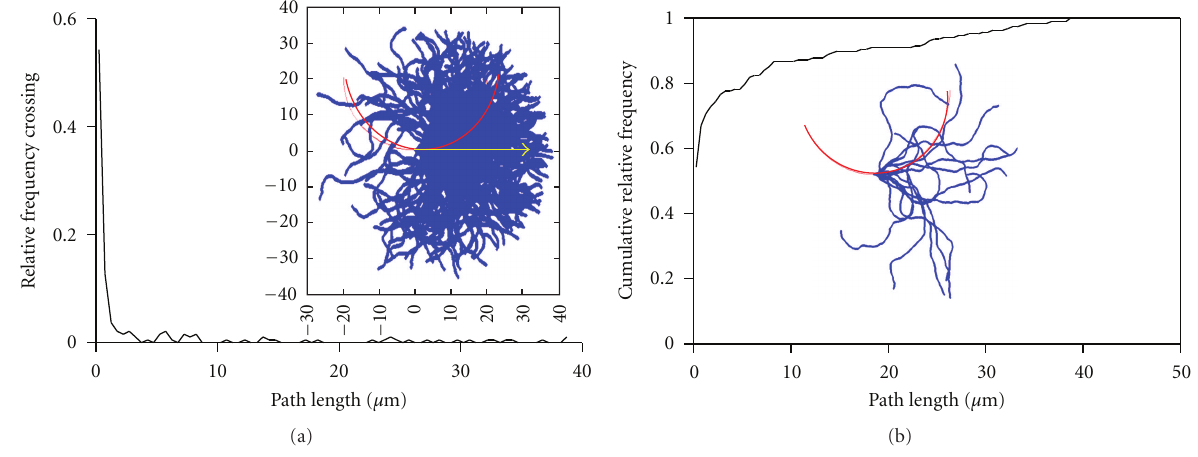
Figure 7: Monte-Carlo simulation of HMM-propelled actin filament sliding ( L P = 10 μ m) without guiding but with the same initial position and sliding direction for all filaments. (a) Distribution of sliding path lengths from onset of motility until the filament, for the first time, moves below red circle arc in inset . Inset: all 200 simulated filament paths starting on the red circular border at the starting point of the arrow. The direction of the latter represents the initial sliding direction. (b) Cumulative frequency distribution corresponding to frequency distribution in (a). Inset: a limited ensemble of 10 simulated filament paths clearly illustrating that also filaments that have moved toward the circle centre tend to rapidly reach and cross the circular